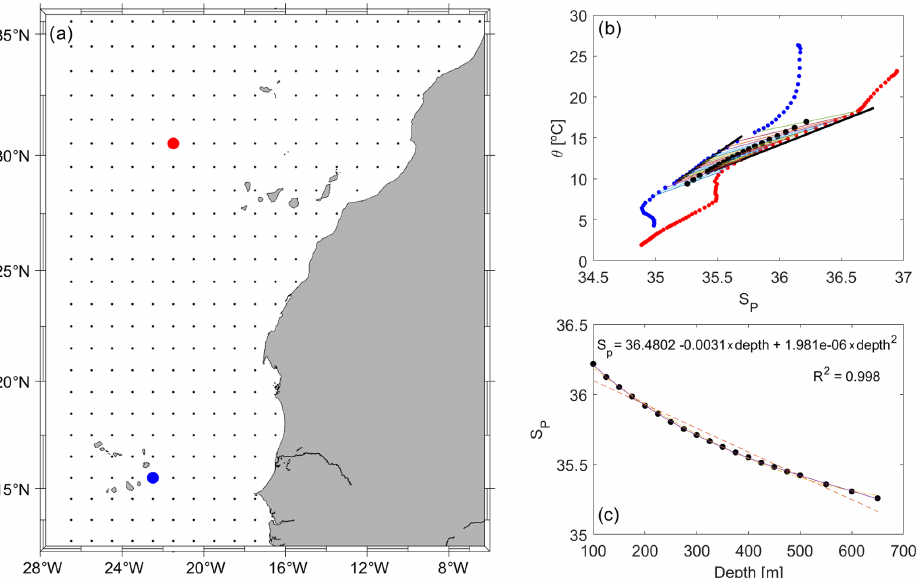
Figure 2. (a) Map showing the two selected WOA stations in the ENACW (red) and SACW (blue) domains. (b) T – S diagram with the average salinity for each depth (in the range from 100 to 650m) shown using black dots between the profiles of the northern and southern WOA stations. Observations at the same depths are connected by a straight line. (c) Linear, quadratic and cubic fits for depth versus salinity with the quadratic fit